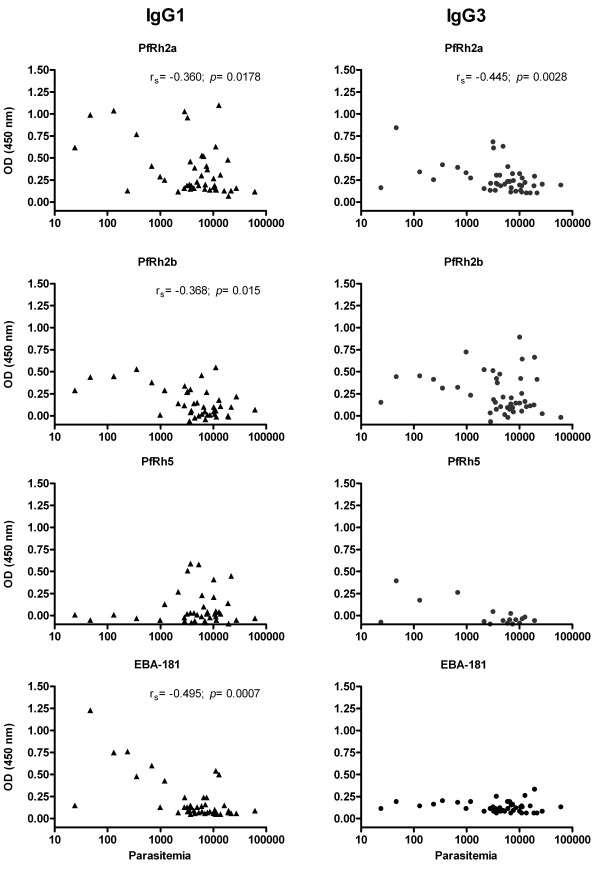
Association between parasitaemia and the IgG1 and IgG3 antibody response to EBA-181, PfRh2a, PfRh2b and PfRh5 P. falciparum ligands. The parasitaemia was determined by light microscopy and expressed as parasites/μL. Spearman correlation coefficient, abbreviated rs, and p value are shown. Triangles, IgG1 and Circles, IgG3.